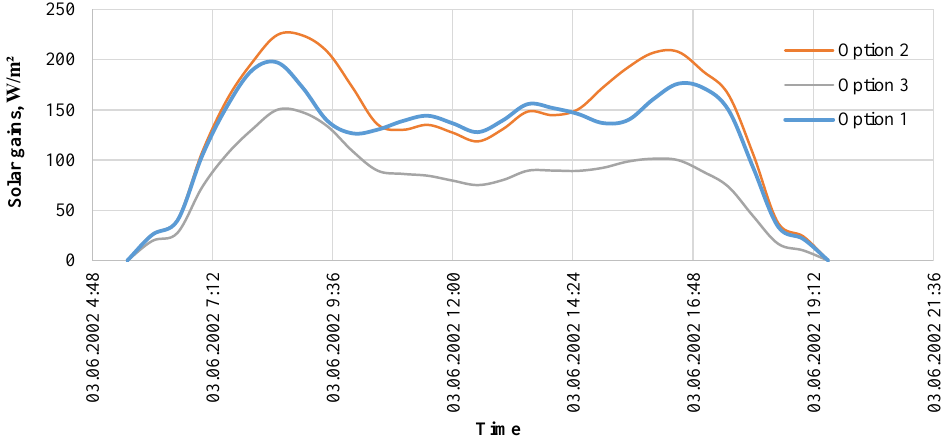
Fig. 10. Comparison of the building solar gains between the 3 options on Monday, June